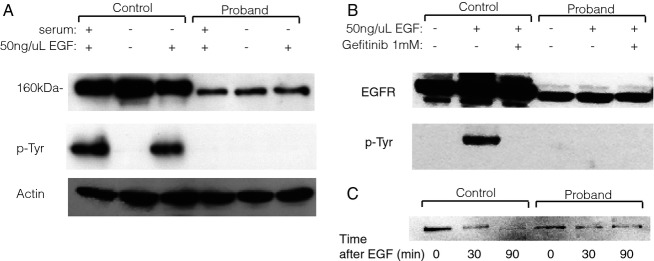
Western blot shows higher levels of EGFR in control compared to patient samples, and higher levels of p-EGFR following EGF stimulation in controls samples, as compared to patients (A). Addition of the EGFR kinase inhibitor gefitinib eliminates EGFR phosphorylation following EGF stimulation and does not change overall EGFR levels (B). Levels of EGFR are decreased at 30 and 90 min following EGF stimulation in control cells, but are unchanged at the same time points in patient cells (C).